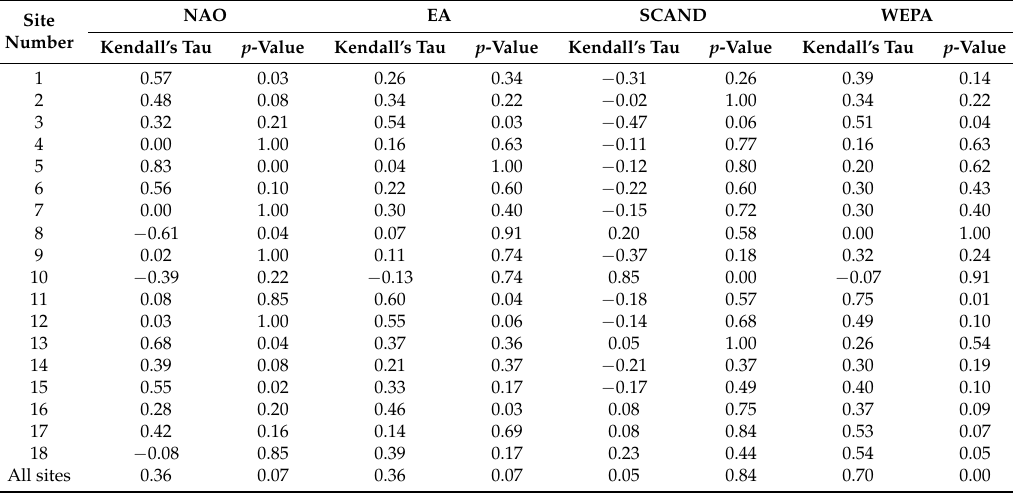
Figure 9. Number of days between consecutive significant wave height extreme events for all sites, showing different return level thresholds for each event. The grey shading at the background of the figures represents the percentage of number of sites for which data are available: the lighter the grey, the more data are available. Table 3. Kendall rank correlation coefficient between the number of extreme wave events that exceeded the 1 in 1-year return level against different atmospheric oscillations indices known to exert influence over the wave climate in the Atlantic